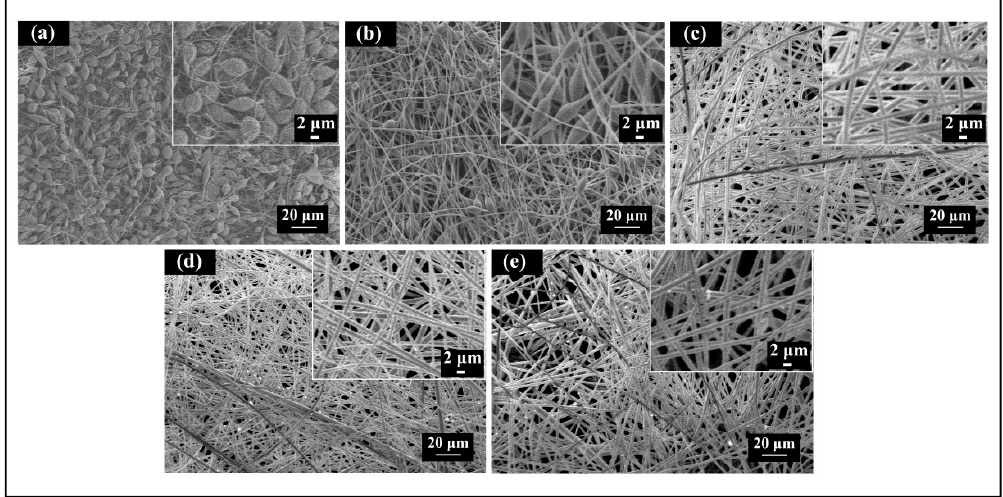
Figure 6. Scanning electron microscopy (SEM) images of electrospun PS fibers formed at different solution concentrations: ( a ) 10 wt %; ( b ) 15 wt %; ( c ) 20 wt %; ( d ) 25 wt %; and ( e ) 30 wt %. The processing parameters were as follows: Applied voltage of 20 kV, working distance of 20 cm, and flow rate of 1.0 mL/h.